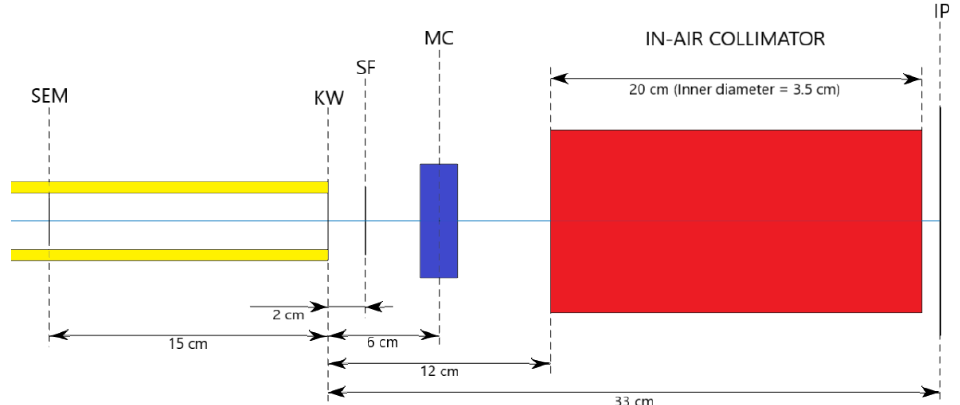
Figure 3. Layout of the in-air part of the beamline. The relative distances of the Secondary Electron Monitor (SEM), the Scattering Foil (SF), the Monitor Chamber (MC), the In-air Collimator, and the Irradiation Point (IP) are referred with respect to the Kapton Window (KW).